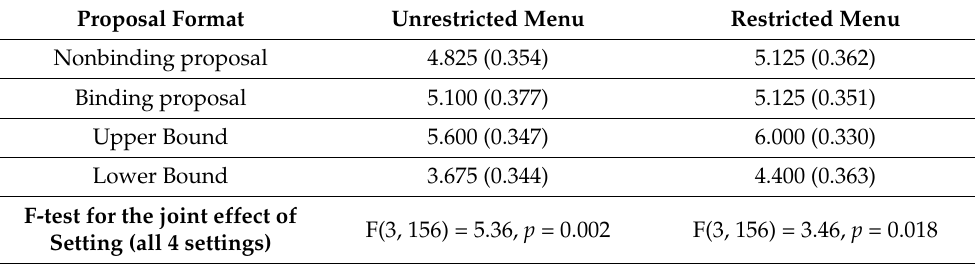
Table 3. Proposer’s average proposal by setting (standard error in parentheses). Forty participants per cell, for a total of 320 participants.